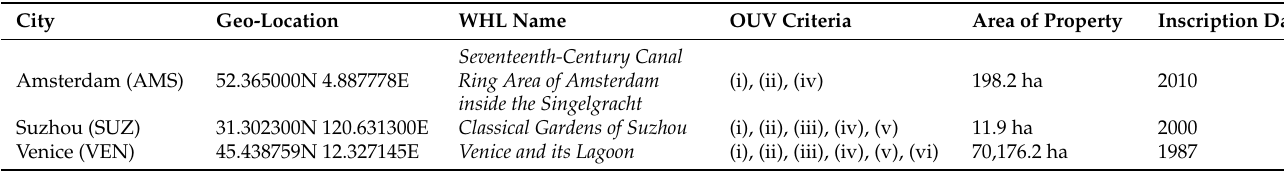
Table 1. The case studies and their World Heritage